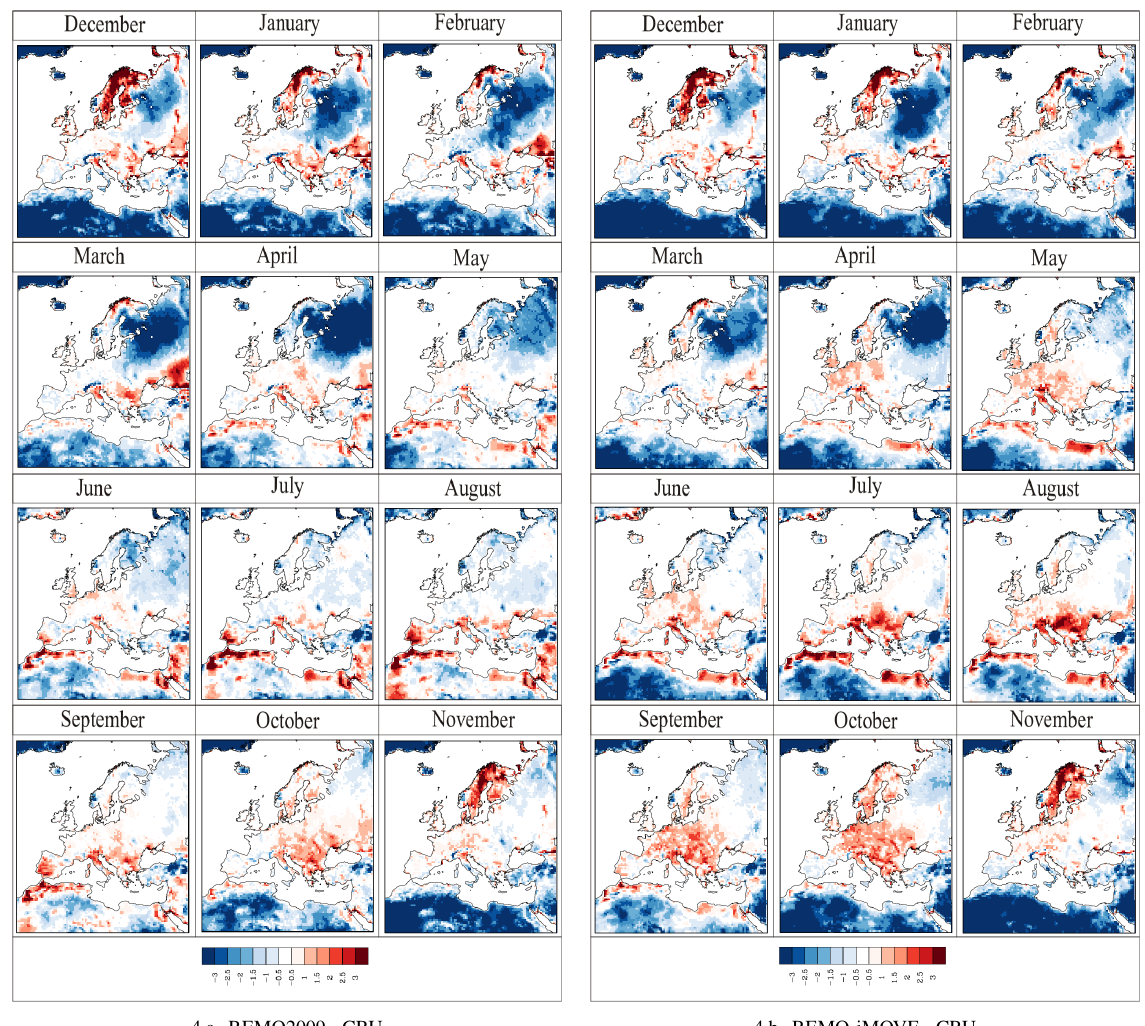
Figure 4. Differences of 2m T of REMO2009 vs. CRU and REMO-iMOVE vs. CRU in the period 1996 to Fig. 4. Differences of 2m-T of REMO2009 vs. CRU and REMO-iMOVE vs. CRU in the period 1996 to 2005